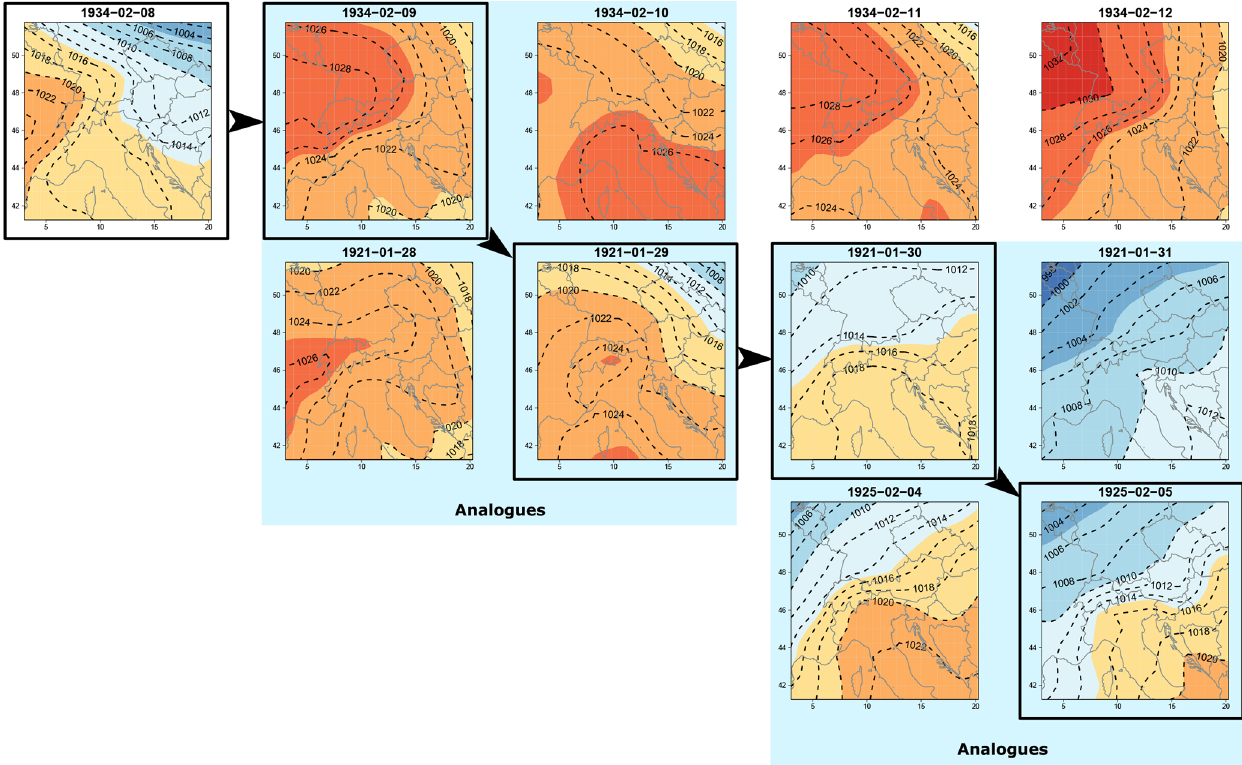
Figure 3. Construction of a new 5d atmospheric trajectory from an observed synoptic weather sequence. Each panel presents the geopotential at 1000hPa on the domain of interest. The black squares and arrows give the new atmospheric trajectory, and the blue shading highlights the 2d analogue that helps the “changing of atmospheric